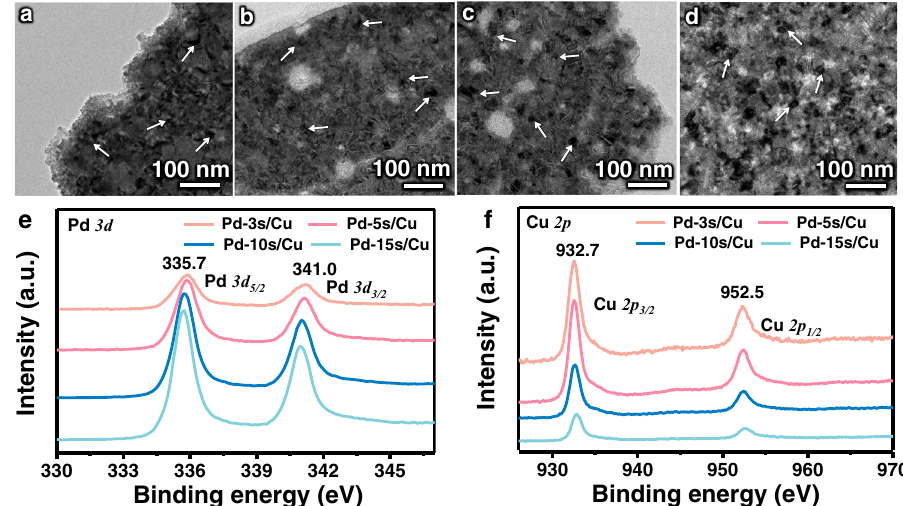
Fig. 1 |CharacterizationofPd/Cu catalysts.a – d TEMimagesof Pd-3s/Cu ( a ),Pd-5s/Cu( b ),Pd-10s/Cu ( c )andPd-15s/Cu( d ). e , f Pd 3d ( e )and Cu 2p ( f )XPSspectraof as- prepared Pd/Cu